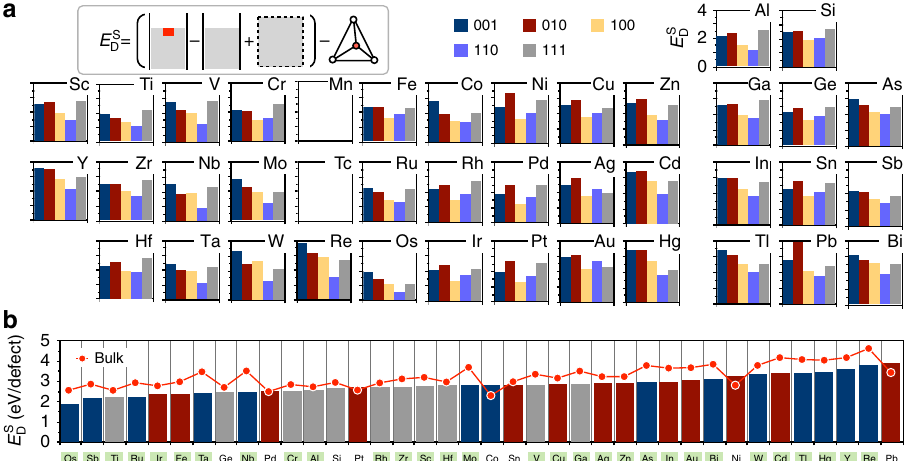
Fig. 2 The defect formation energy for each stable surface facet. a The defect formation energies are varied in accordance with the facets. The inset schematic illustrates how the formation energy was obtained. b An ascending list of the surface doping formation energy of each dopant, where the green labels indicate elements which preferentially occupy the surface region, obtained from Fig. 1